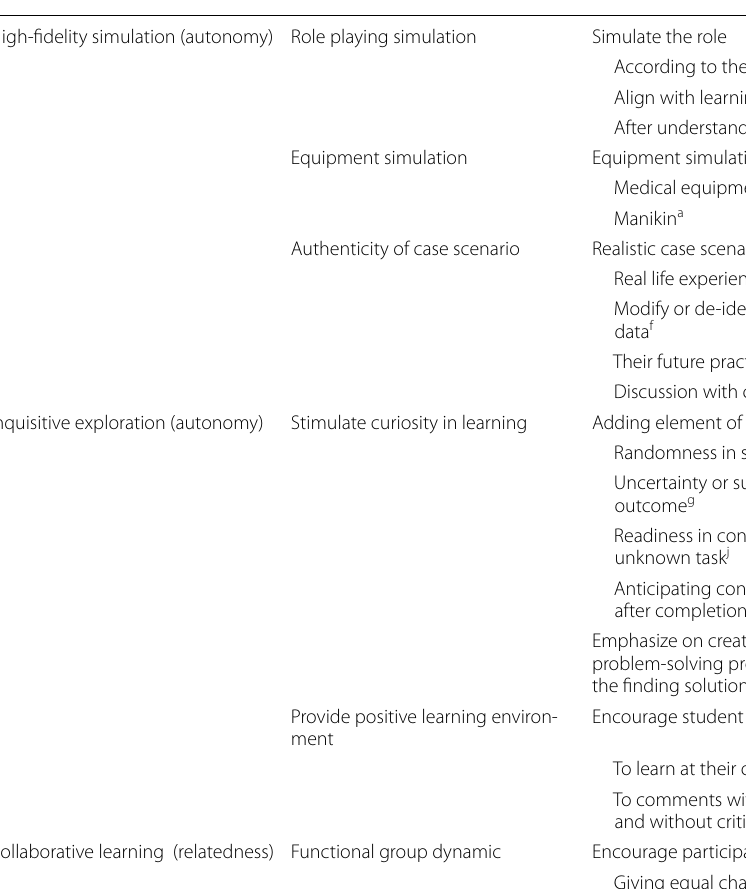
Table 3 The results of thematic analysis